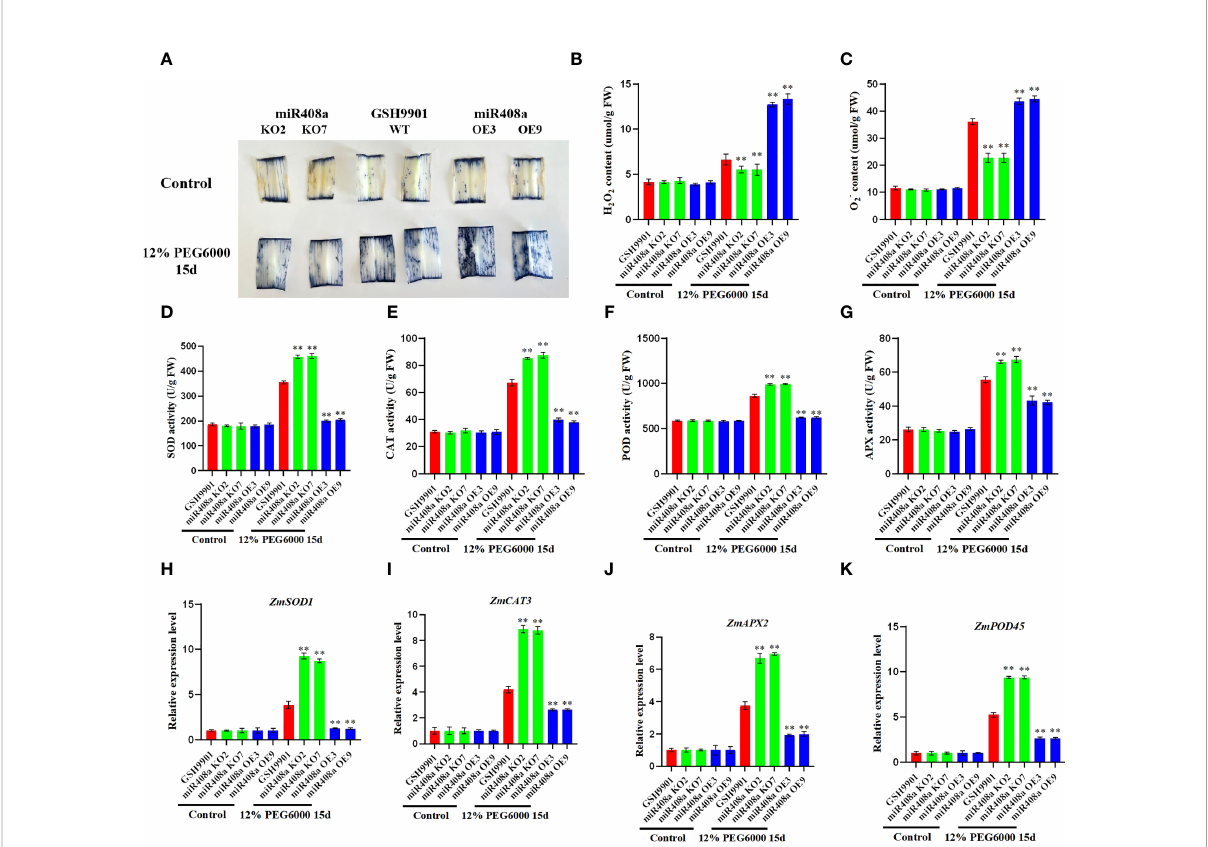
FIGURE 8 ZmmiR408a reduced drought tolerance by regulating ROS accumulation in maize. (A) Nitrotetrazolium Blue chloride (NBT) staining of wildtype, miR408a-KO, and miR408a-OE plants were conducted drought treatment for 15 days, which was used to monitor the ROS production in drought-treated leaves. (B, C) Hydrogen peroxide (H 2 O 2 ) content and Superoxide radical (O 2 − ) content in leaves. (D – G) Analysis of catalase (CAT), superoxide dismutase (SOD), peroxidase (POD), and ascorbate peroxidase (APX) activity in drought-treated leaves. (H – K) Analysis on expression patterns of ROS-related Marker genes in drought treated leaves. The expression level was normalized to that of Maize Actin. Data were expressed as the mean of triplicate values and error represented the SD, p < 0.05 (*) and p < 0.01